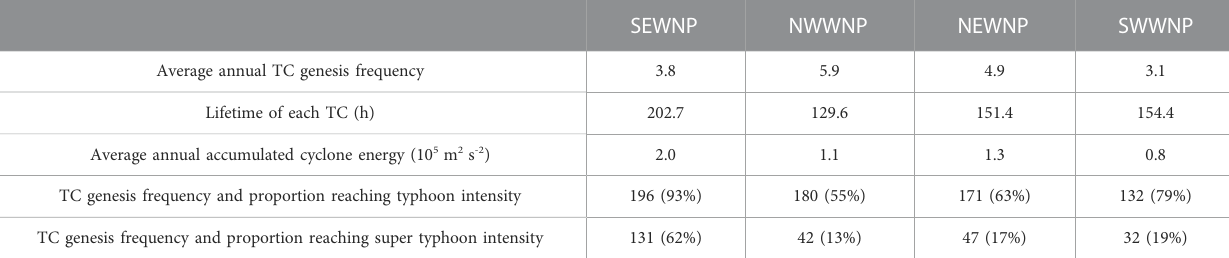
TABLE 1 Characteristics of TCs generated in the four subregions of the WNP in JJASON during 1965 – 2019.